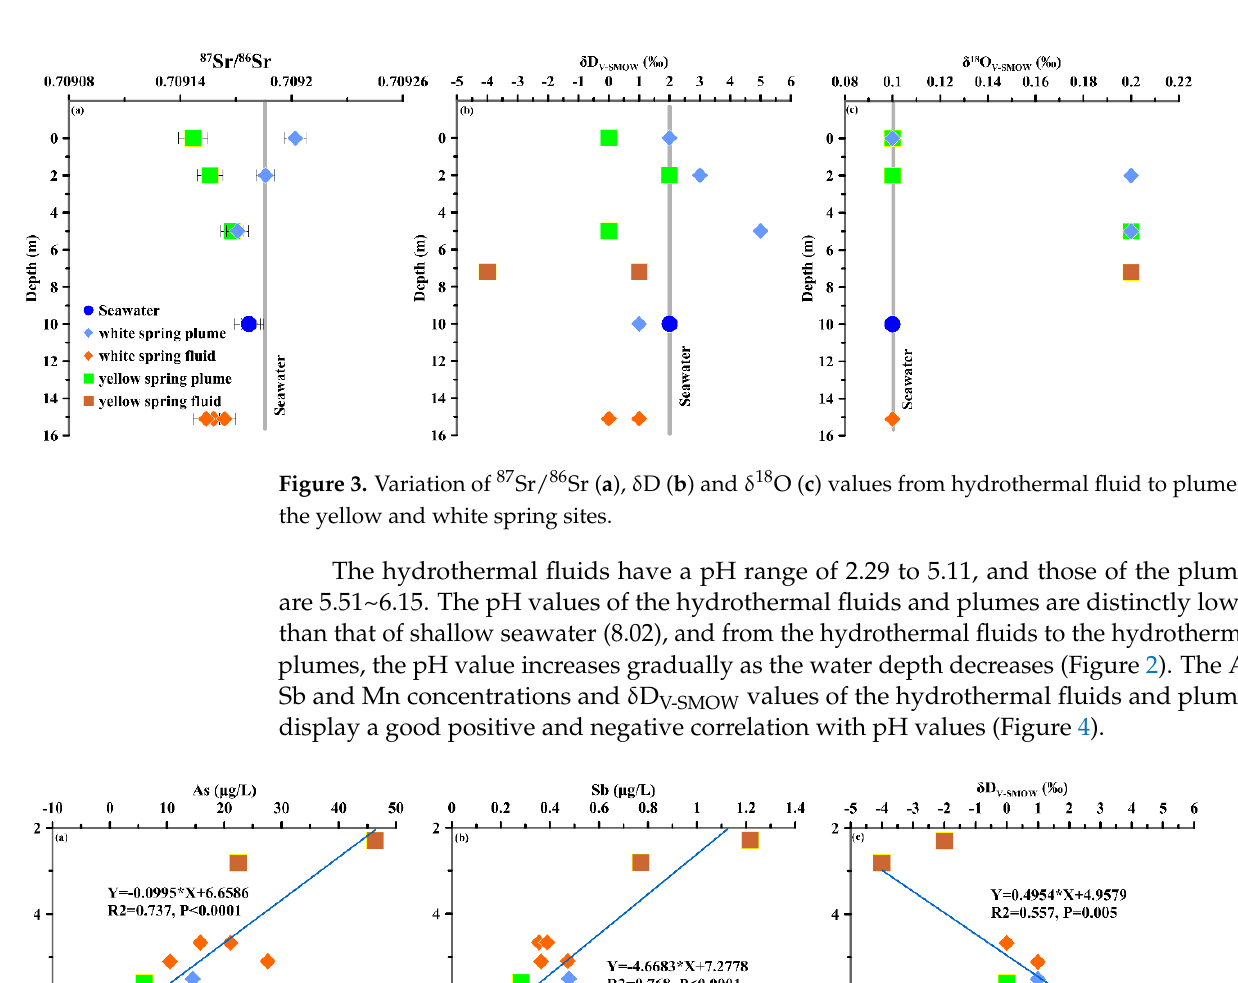
Figure 3. Variation of 87 Sr/ 86 Sr ( a ), δ D ( b ) and δ 18 O ( c ) values from hydrothermal fluid to plume at the yellow and white spring sites.